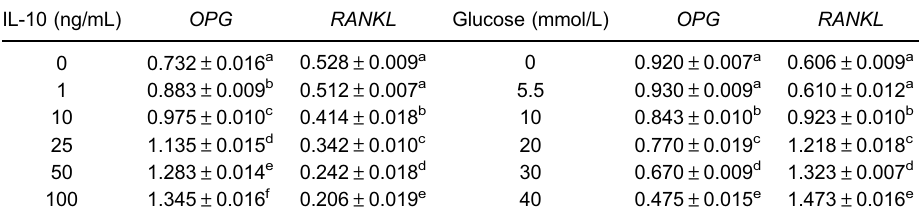
Table 2. Relative mRNA expression of osteoprotegerin (OPG) and receptor activator of nuclear factor- k B ligand (RANKL) in human periodontal ligament fi broblasts after interleukin-10 (IL-10) or glucose treatment. IL-10